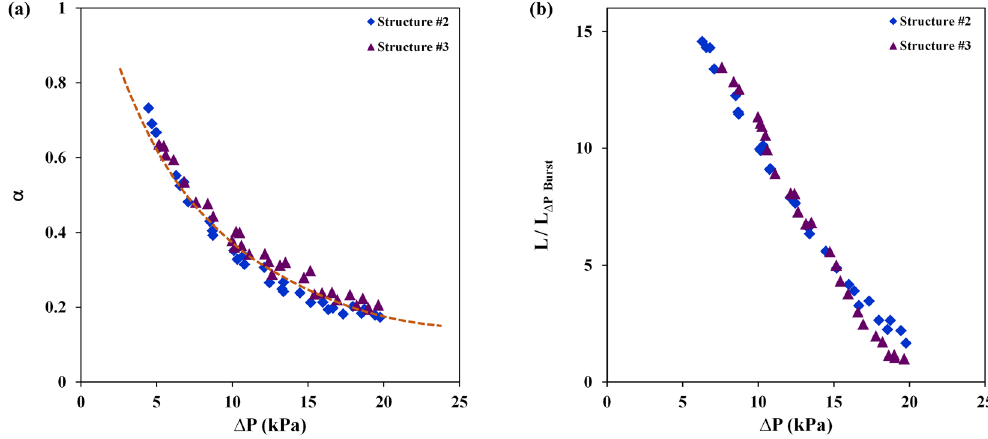
Figure 7. ( a ) CHF dependence on α as a function of liquid pressure (reported values are calculated using equation 3 where k = 2, 3 and j = 1). ( b ) Normalized wicking length as a function of liquid